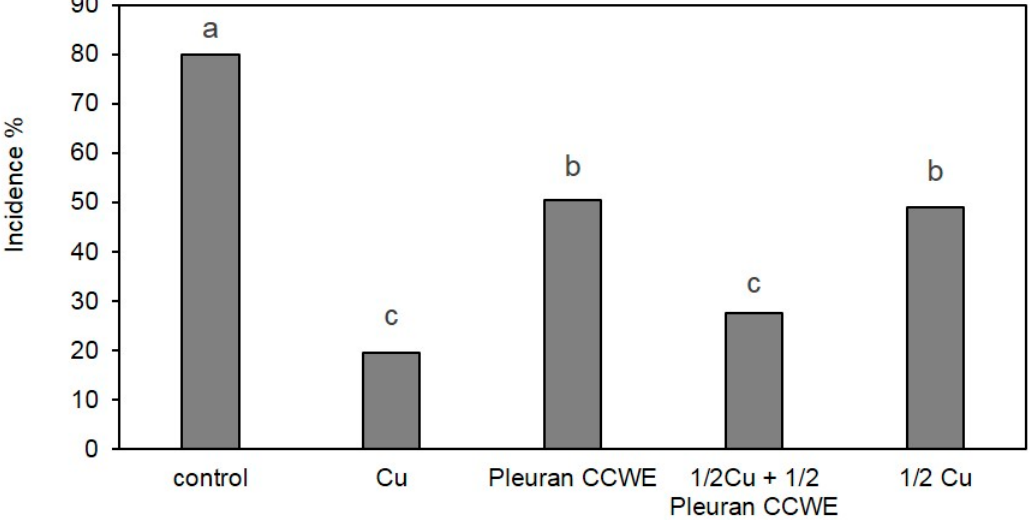
Figure 7. Effect of Pleuran CCWE treatment on incidence of downy mildew on grapevine (field trial, notation 20 July 2015) compared with conventional treatments based on Cu and alternative treatment combining Cu and Pleuran CCWE. % of attacked grapes. (Newman–Keuls test).